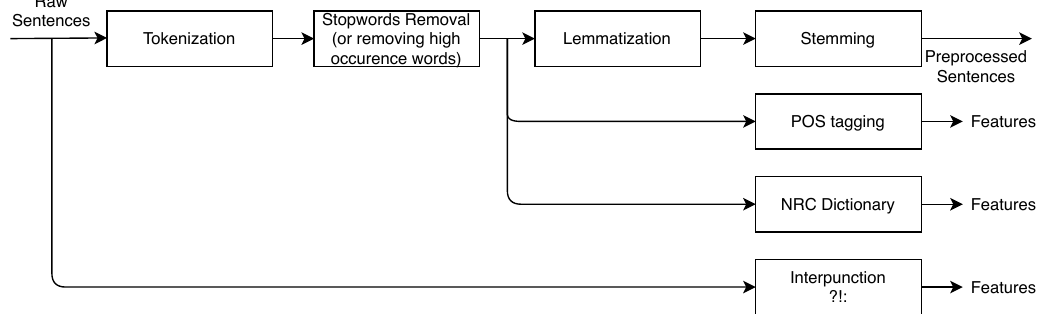
Figure 8. Process of cleaning and preparing data for